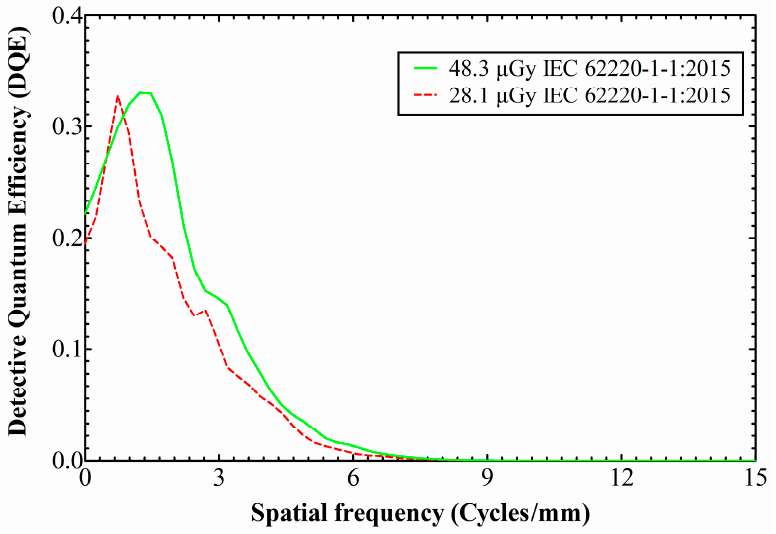
Figure 7. DQE curves for both the examined exposures.